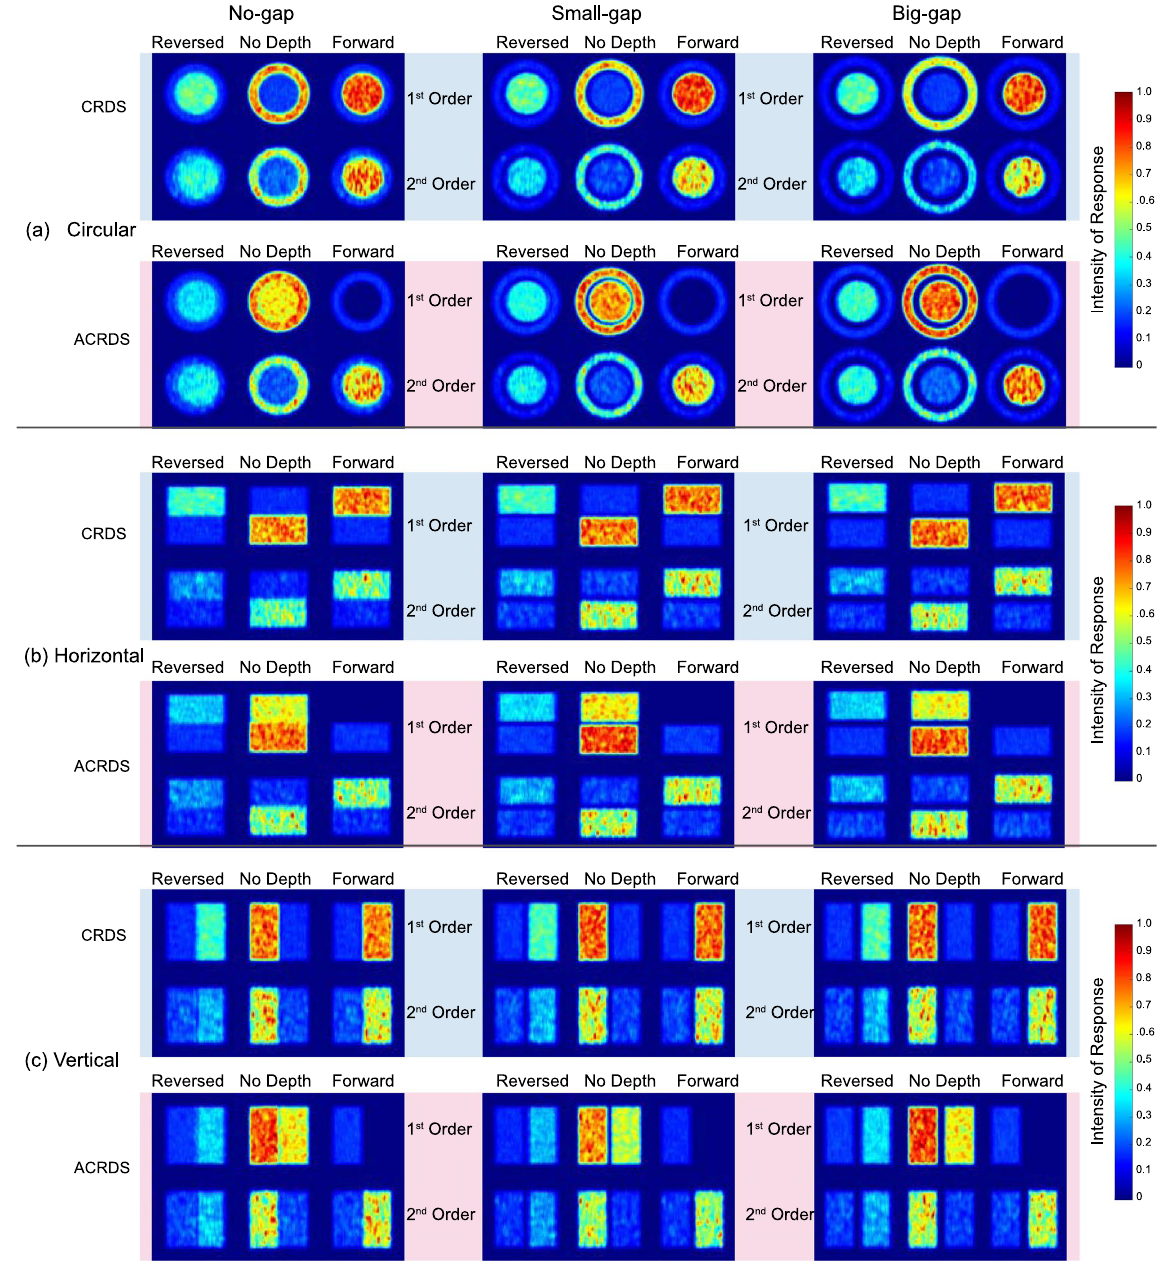
Figure 12. Heatmaps for all nine conditions of the simulation for our specific stimuli. Circular stimuli are on the top ( a ), horizontal in the centre ( b ) and vertical at the bottom ( c ). Each shape has rows for CRDS (top) and ACRDS (bottom), and the gaps in columns, with no-gap (left), small-gap (middle) and big-gap (right). The reversed column shows results for filters tuned to an uncrossed disparity of 10 arc min, the no-depth column for filters tuned to zero disparity, and the forward column for filters tuned to a crossed disparity of 10 arc min. Responses were summed over the three spatial frequencies and 20 trials. Results were normalised separately for the first- and second-order channels by dividing by the maximum mean response. In all cases, the correlated zero-disparity reference produces a strong response in the zero-disparity-tuned filters. For the first-order channel, a stronger response to the target is evident in the forward (CRDS) or reverse (ACRDS) direction. In contrast, for the second-order channel a stronger response to the target is evident in the forward direction for both CRDS and